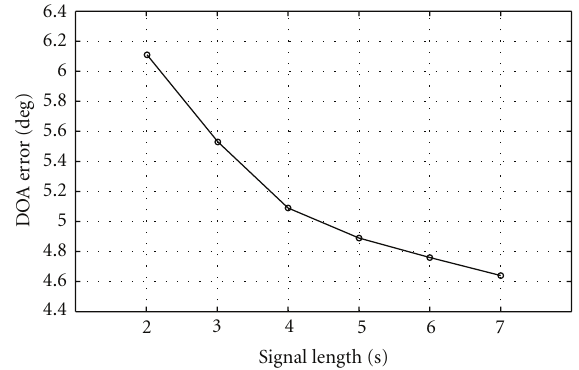
Figure 5: Overall mean absolute error in estimated DOAs (in degrees) obtained by the proposed algorithm as a function of the frame length when two microphones are used and three sources are present. The signal length of 4s was used.